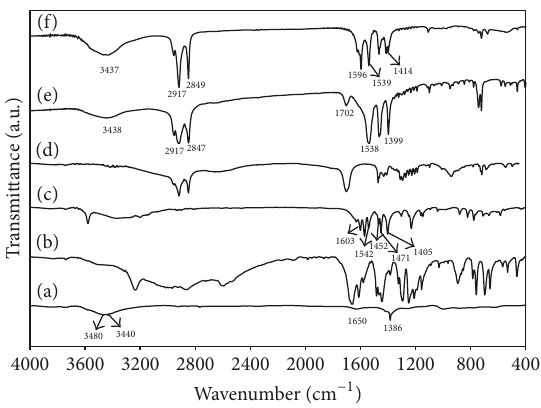
Figure 3: FTIR spectra of the fillers: (a) zinc hydroxide nitrate (ZHN), (b) salicylic acid, (c) LHS (salicylate), (d) palmitic acid, (e) LHS (palmitate), and (f) Zn/Al palmitate.